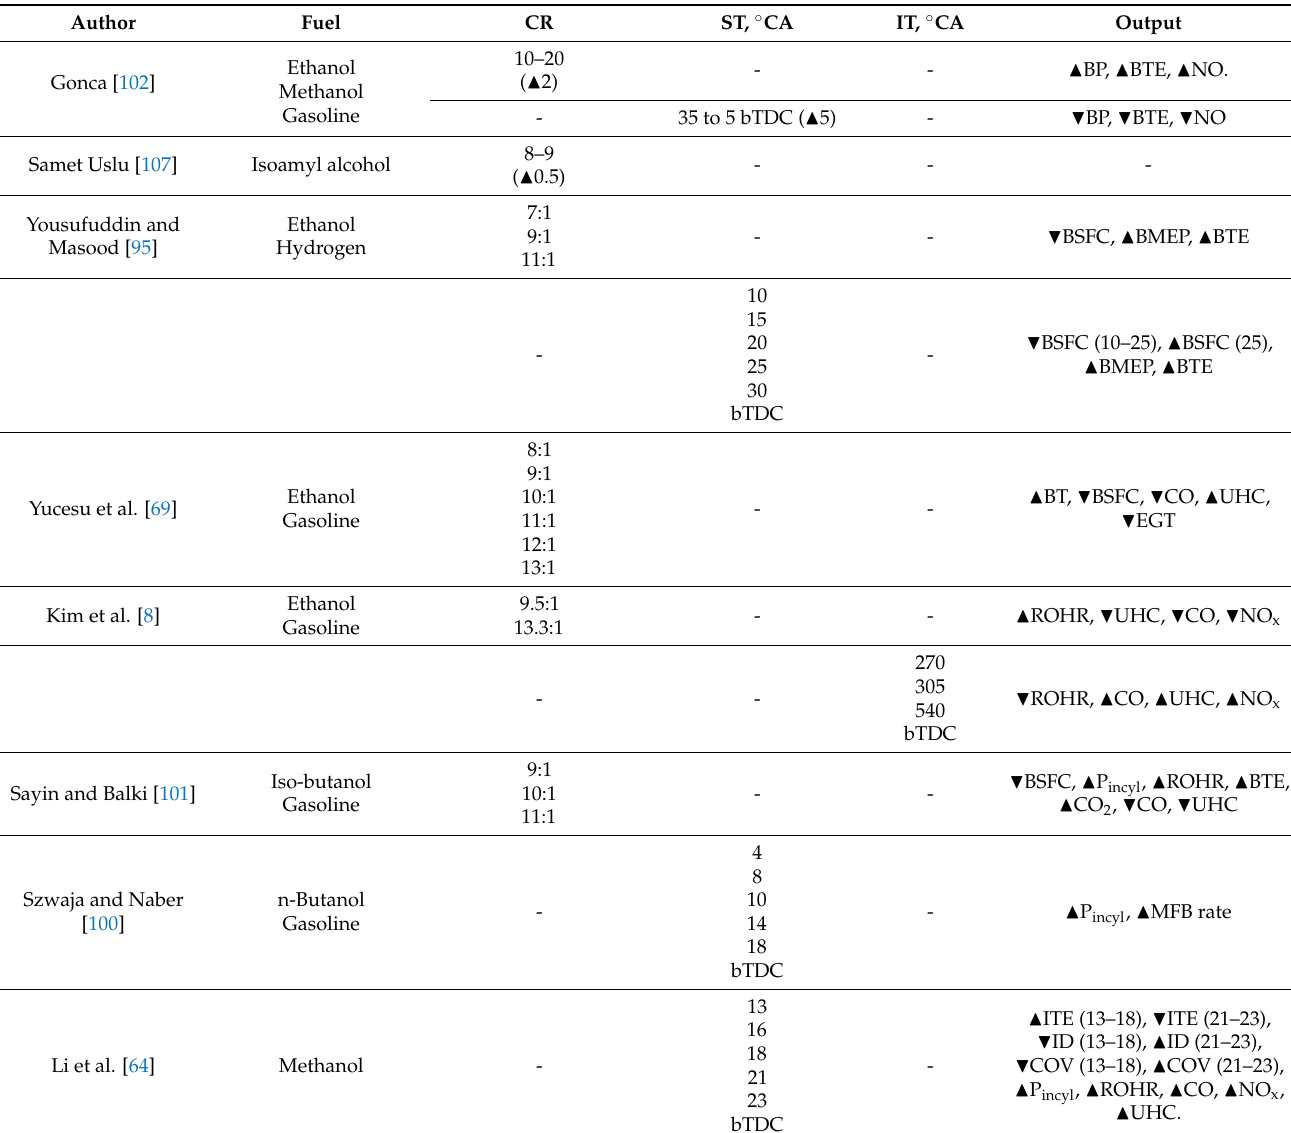
Table 3. The effects of various compression ratios, ignition timings, and injection timings on SI